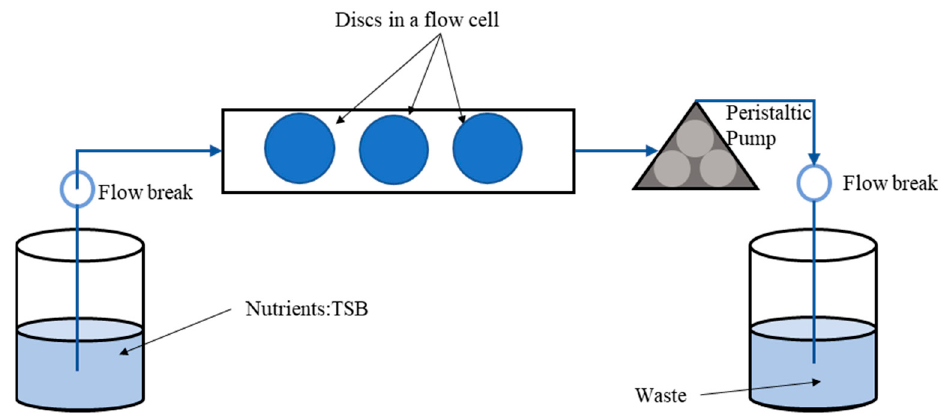
Figure 1. Schematics of experimental setup for growing biofilm in a flow through system.